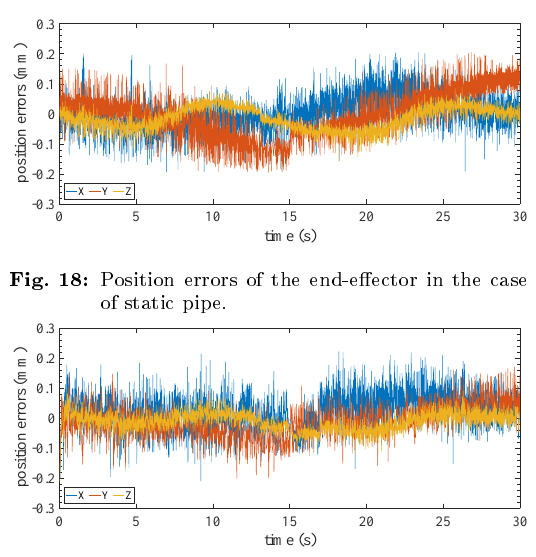
Fig. 19: Position errors of the end-e(cid:27)ector in the case of rotary pipe.